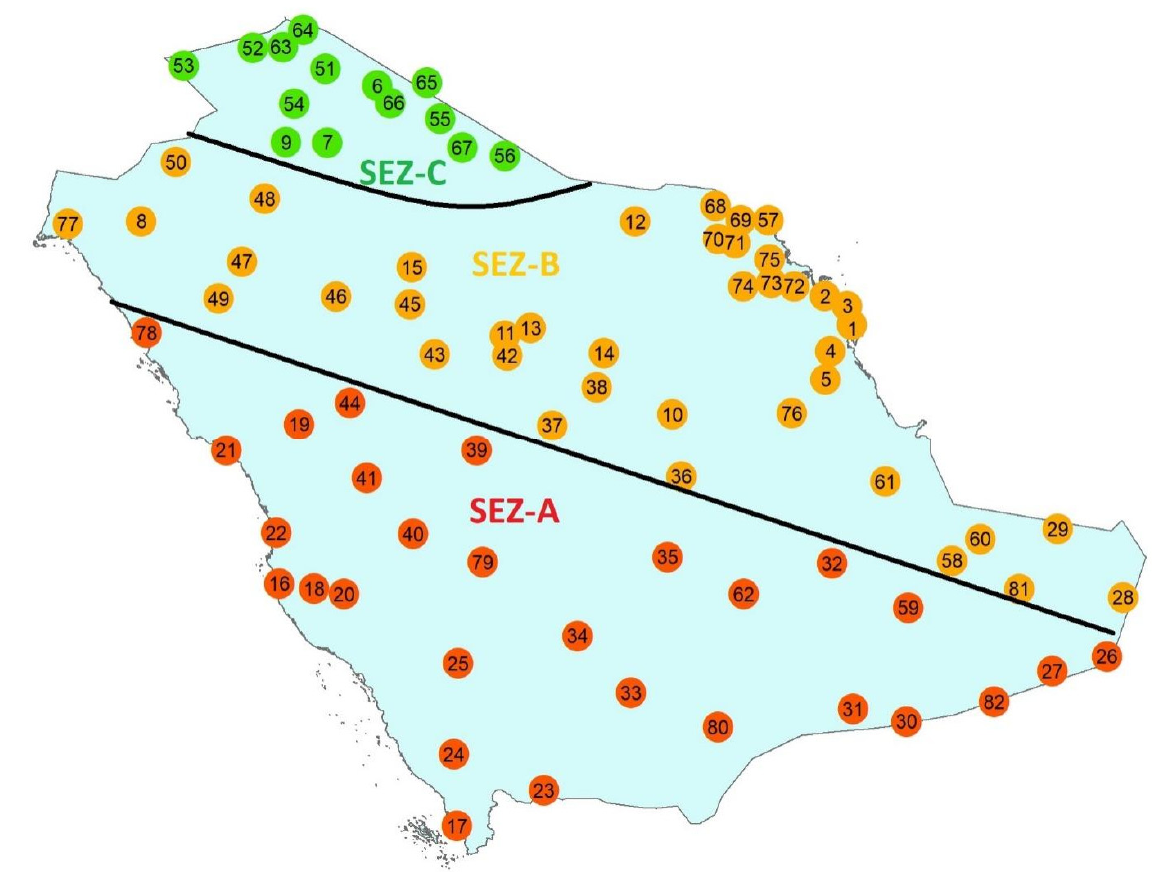
Figure 2. Distribution of the 82 sites in Saudi Arabia into the 3 identified SEZs. For configuration- type-(i) solar systems, the optimum tilt angle is: β = 20° S (SEZ-A), β = 25° S (SEZ-B), β = 30° S (SEZ- C). For configuration-type-(ii) solar systems, the optimum tilt angle is: β = 40° (SEZ-A), β = 45° (SEZ- B), β = 50° (SEZ-C). For configuration-type-(iii) solar systems, the tilt angle is always varying, and